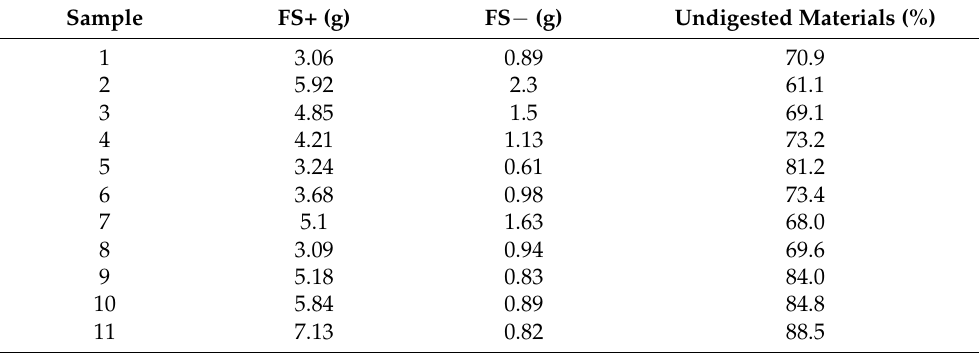
Table 2. Masses of collected fecal samples. Masses from individual fecal samples prior to removal of undigested materials (FS+) and following their removal (FS −